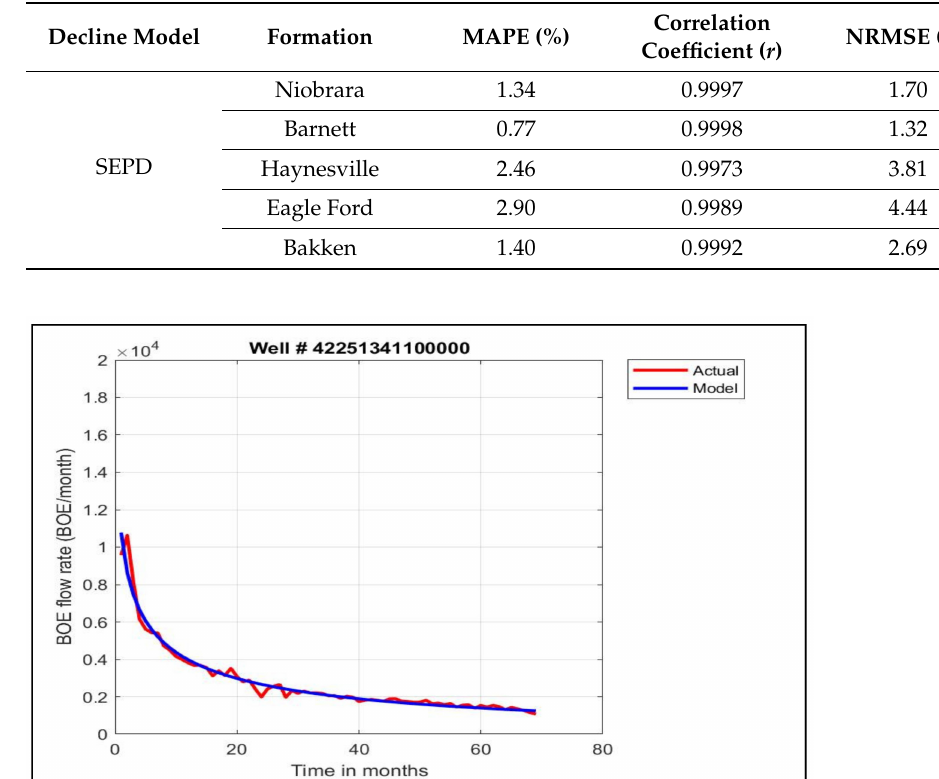
Figure 5. Example of production history matching of entire production history data with the SEPD model for a well in the Barnett